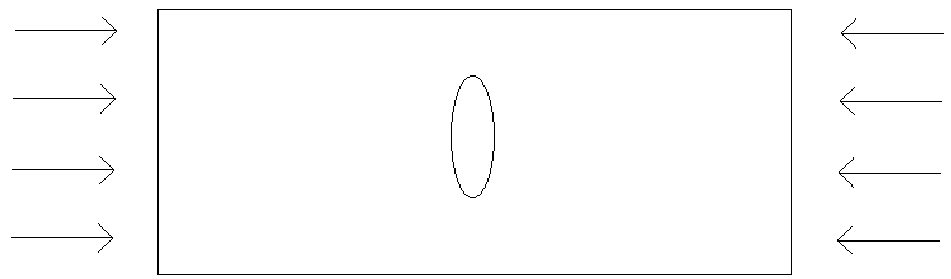
Figure 13. Original crack shape of [( ∓ 45C) 2 ,(90C,90G) 4 ,( ∓ 45C) 2 ] specimen and load direction in CAI test.